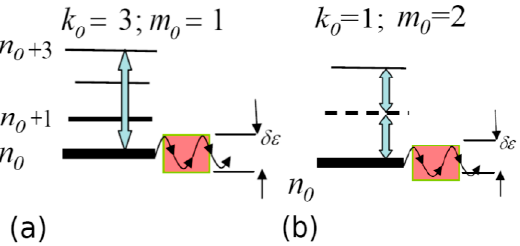
Figure 5. Schematic of nonlinear dynamic resonances of different { k 0 m 0 } orders for the initial quantum state n 0 : ( a ) single-photon ( m 0 = 1) and ( b ) double-photon ( m 0 = 2) resonances.